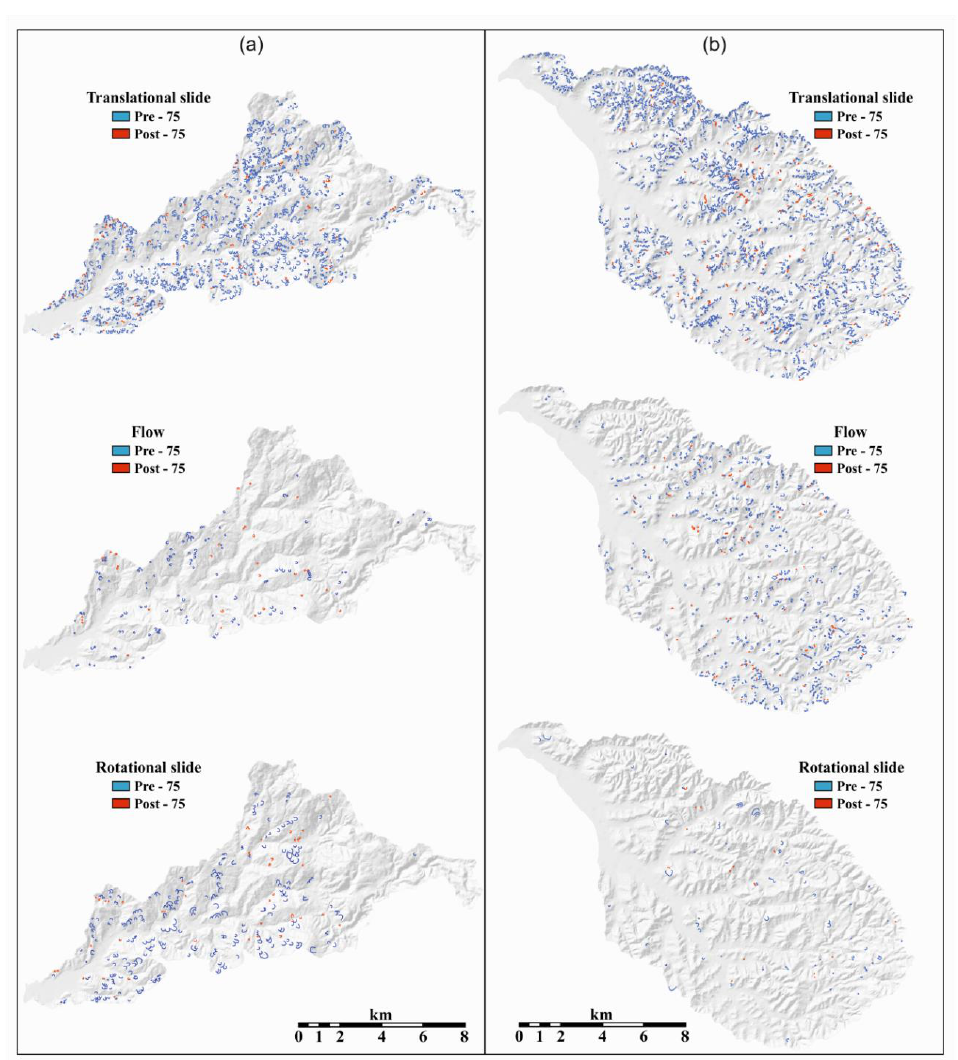
Figure 3. Inventory of the landslides occurred pre and post 1975 in the Milia ( a ) and Roglio ( b ) basins.